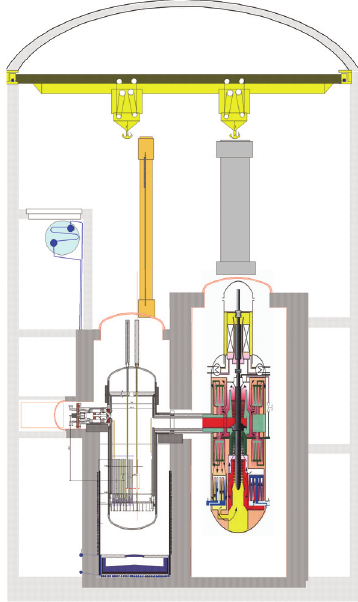
Figure 2: Proposed layout for a 600MWth GFR with direct